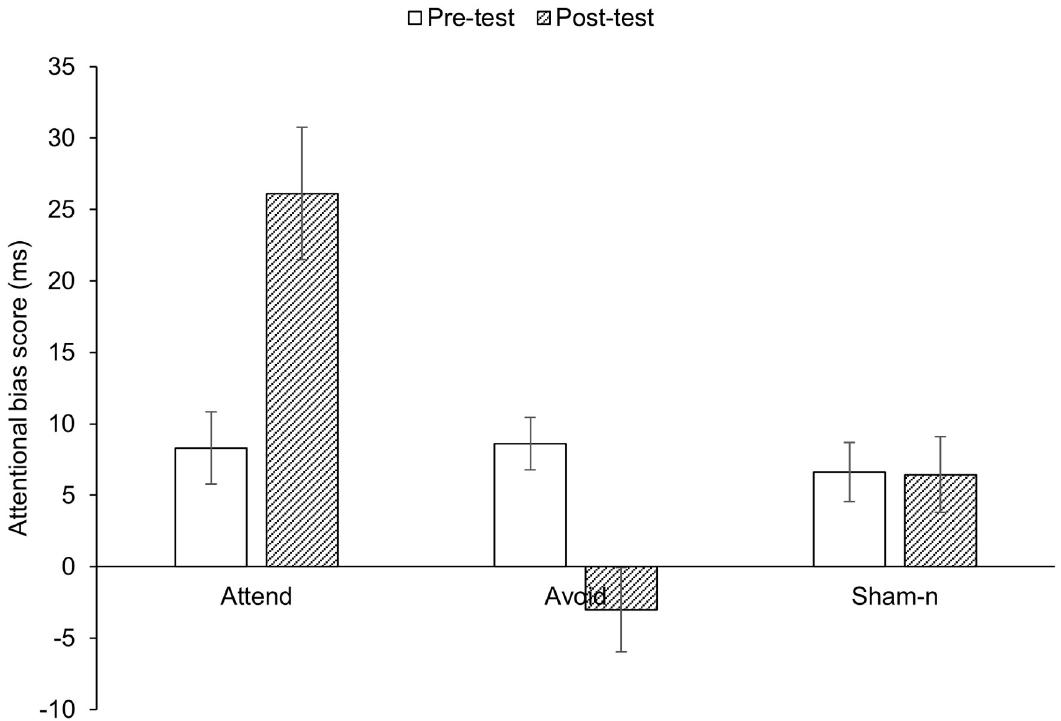
Fig 2. Mean attentional bias scores (with standard errors) for attend, avoid and sham-n training conditions at pre- and post- test.